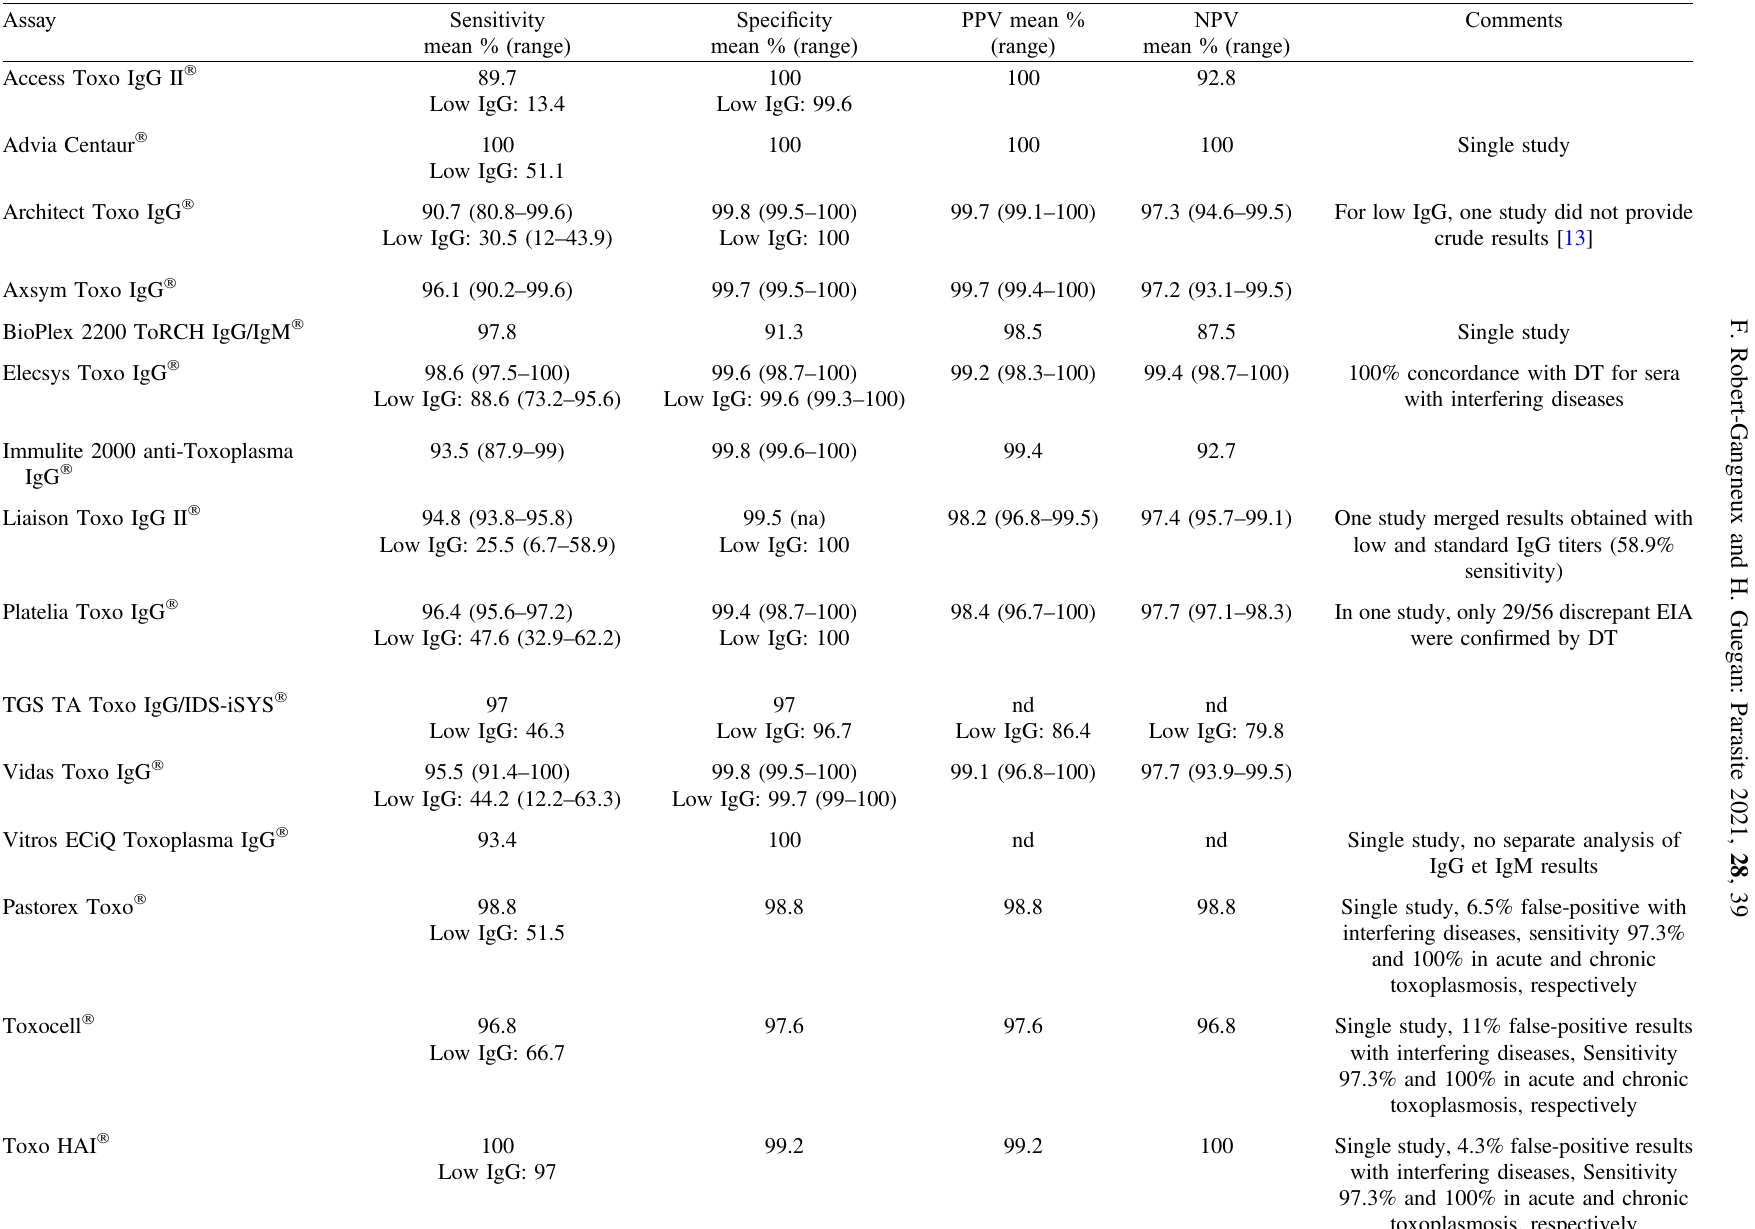
Table 2. Sensitivity, Speci fi city, PPV and NPV of anti- Toxoplasma IgG commercial assays included in the study.